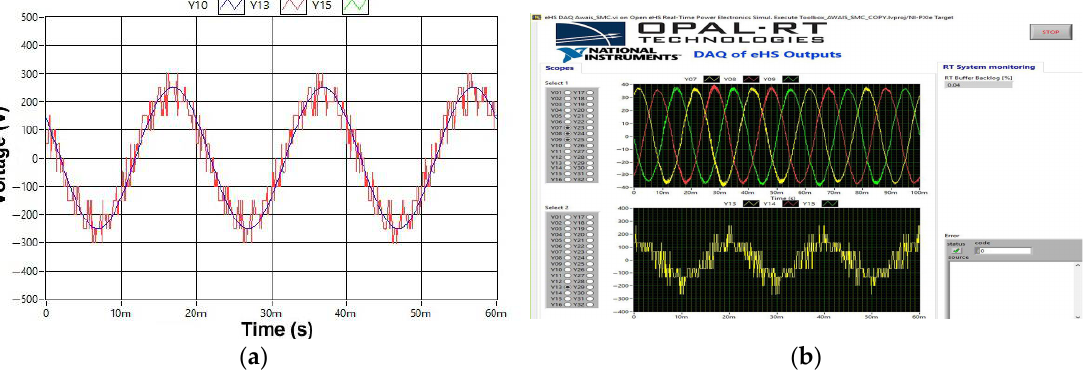
Figure 12. OPAL-RT front panel results: ( a ) single phase inverter output voltage; ( b ) three-phase output current with single-phase inverter output.